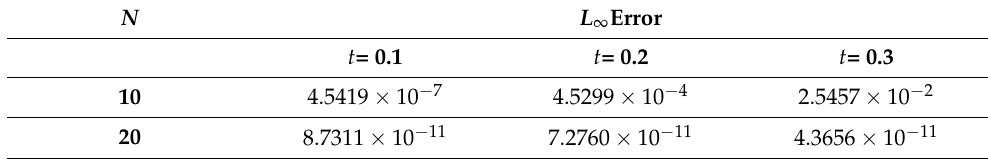
Table 7. Error analysis regarding Example